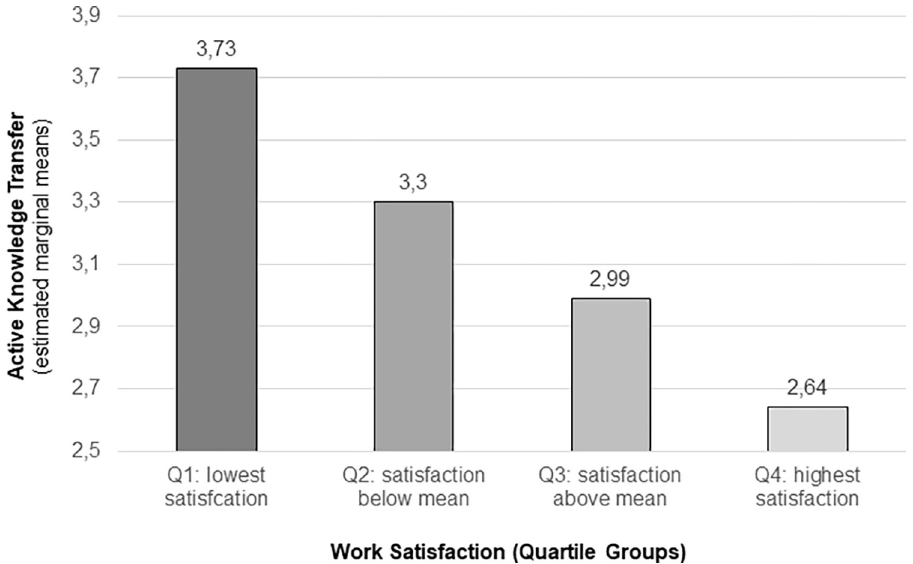
Fig 2. Effect of satisfaction level (quartile groups from highest to lowest) on active knowledge transfer.